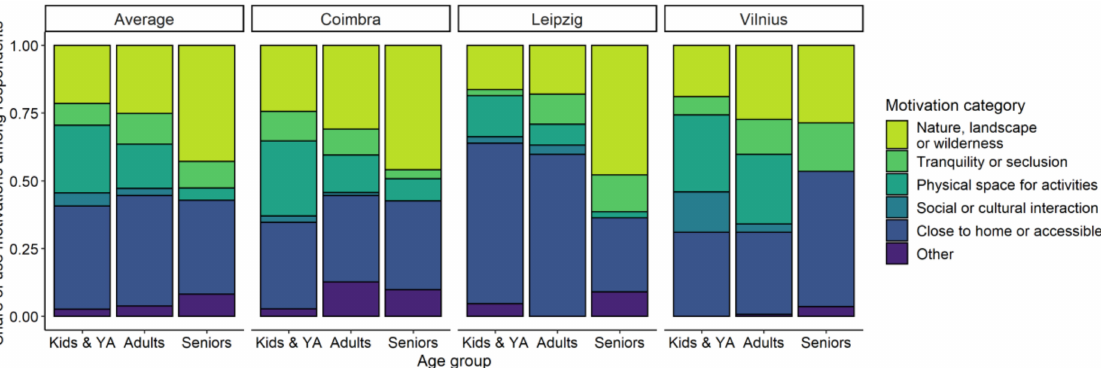
Figure 4. Motivations for park visits by